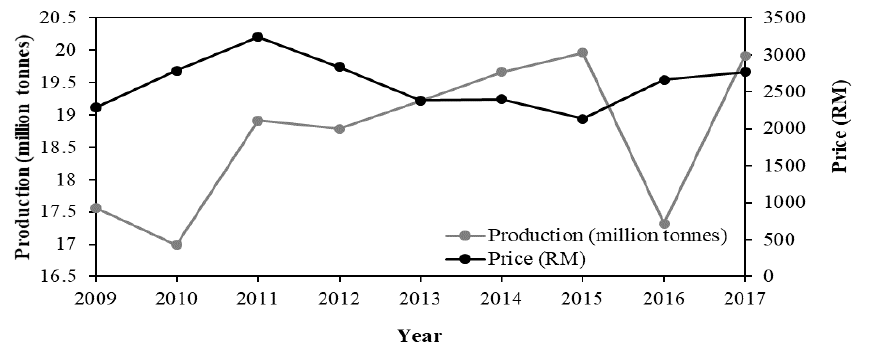
Figure 3. Annual production of crude palm oil (CPO) in Malaysia and prices [16].